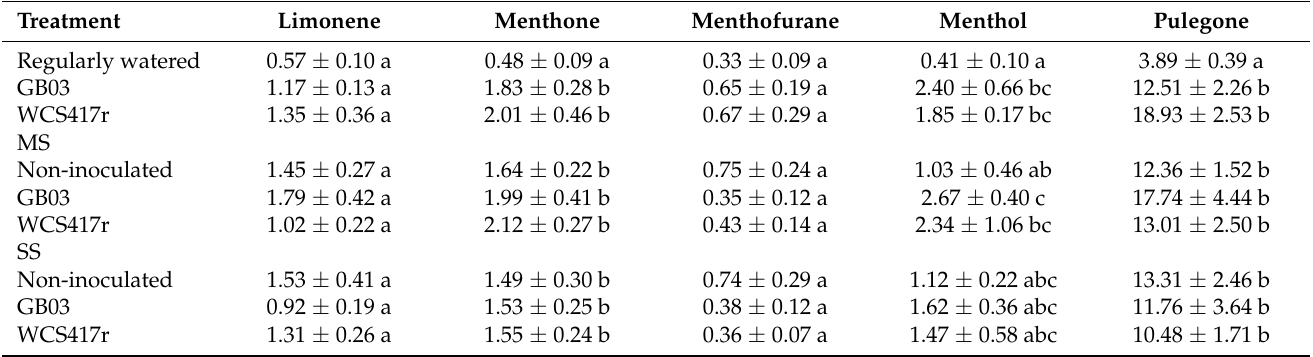
Table 2. Concentrations of major Essential Oil (EO) components ( μ g/g fresh weight) in Mentha piperita plants grown under drought stress (MS: moderate stress, SS: severe stress) and inoculated with different plant growth promoting rizobacteria (PGPR) strains (mean ± SE). Means followed by the same letter in a given column are not significantly different according to Fisher’s LSD test (n = 15–20, p < 0.05).